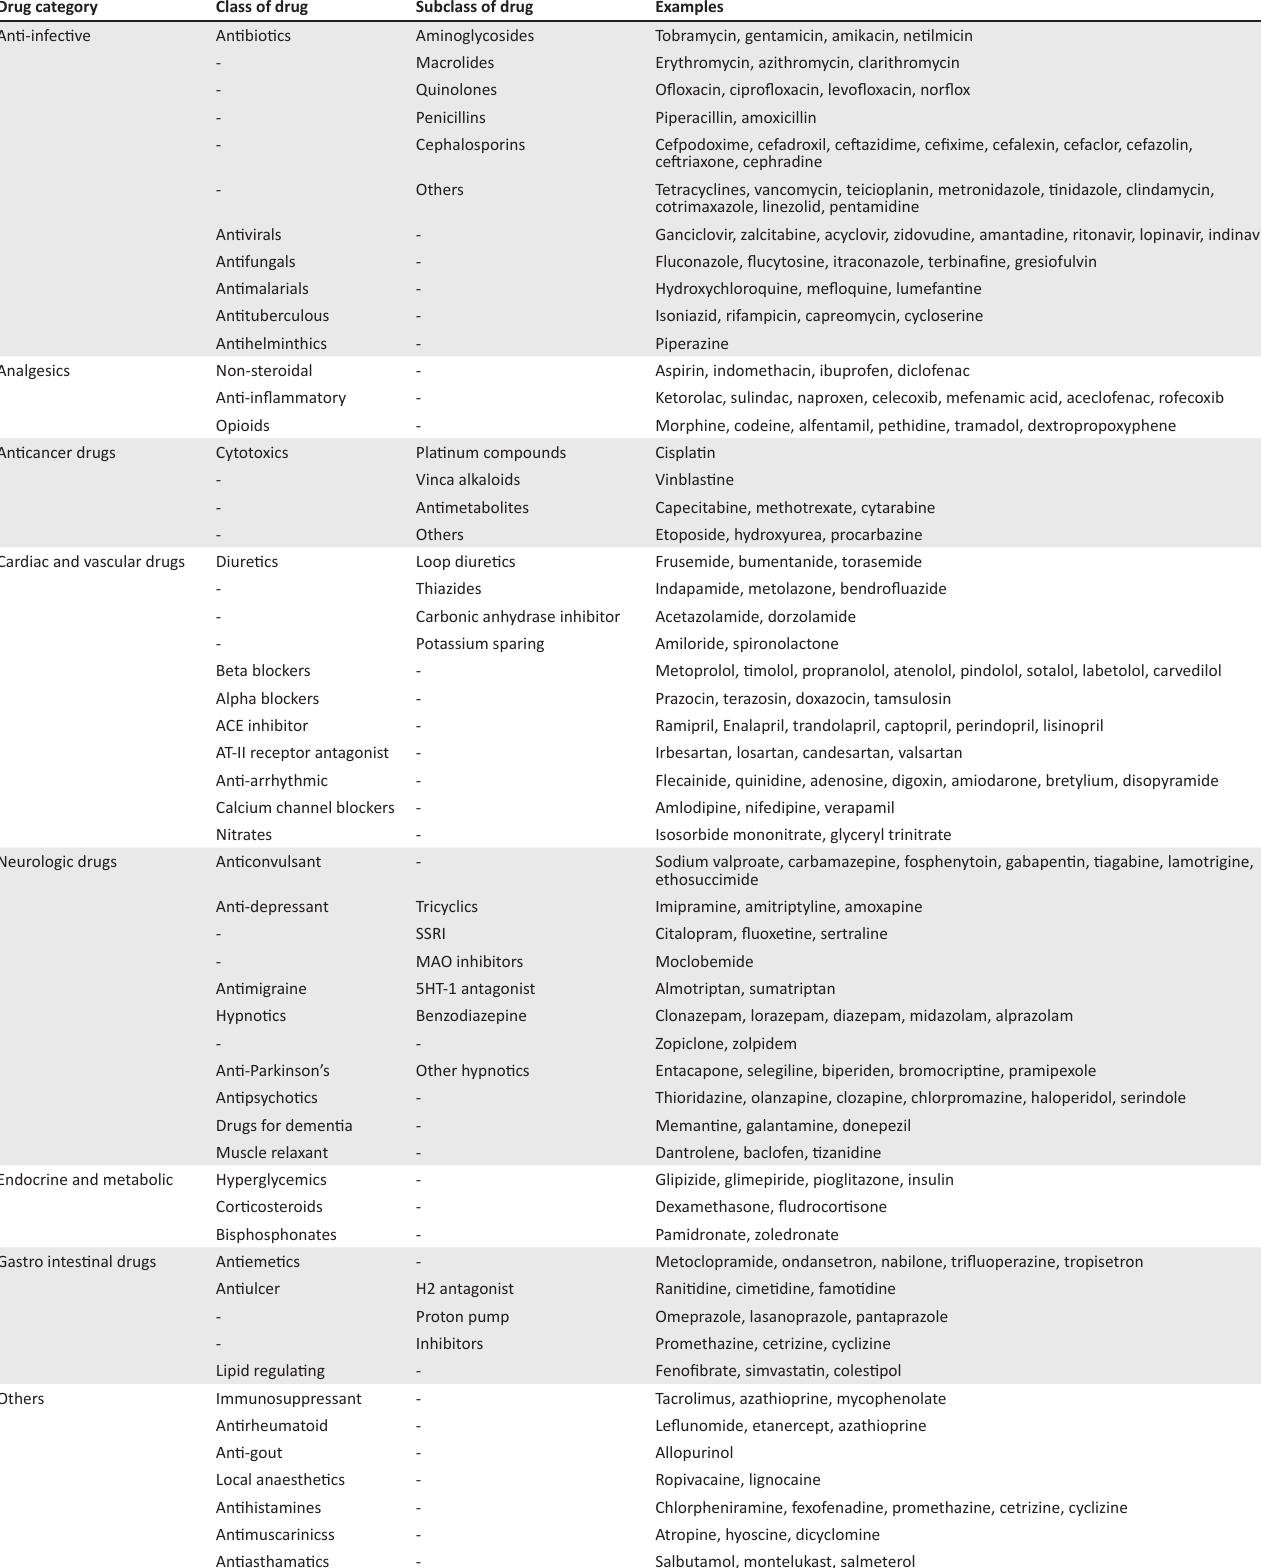
TABLE 3-A1: Drugs causing vertigo or dizziness as a side effect. Drug category Class of drug Subclass of